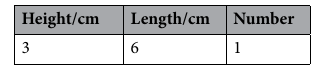
Table 1. The datum parameter set.